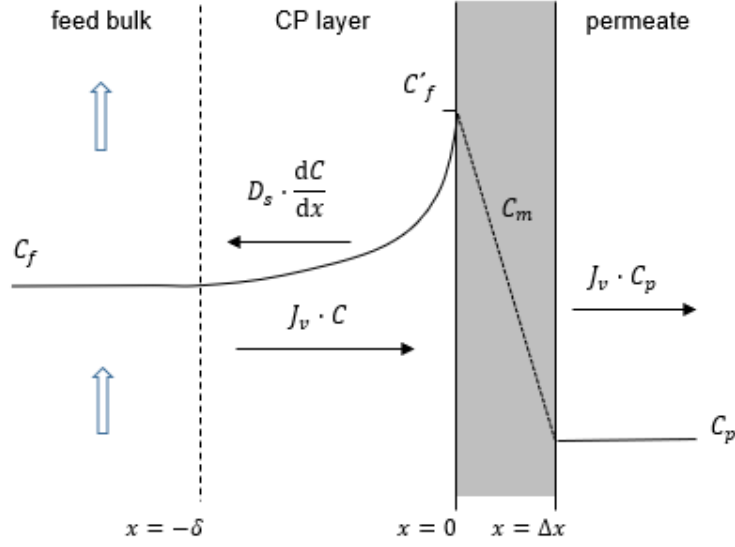
Figure 2. Concentration polarization in the membrane boundary layer.